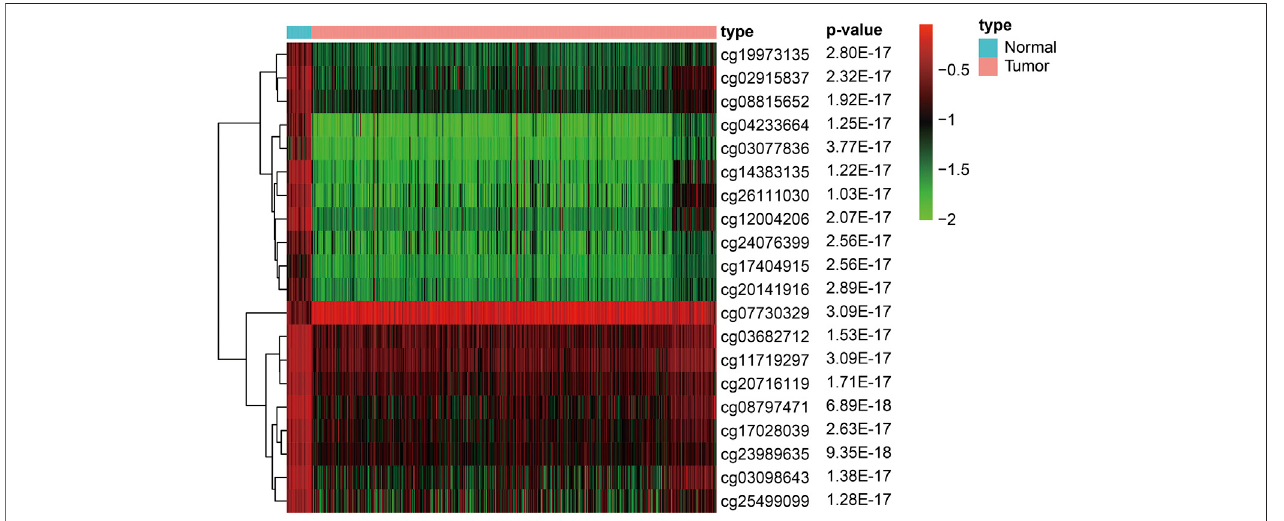
FIGURE 1 | Heat map of the top 20 signi fi canly different methylation sites in gastric cancer (Arranged in p -value order).